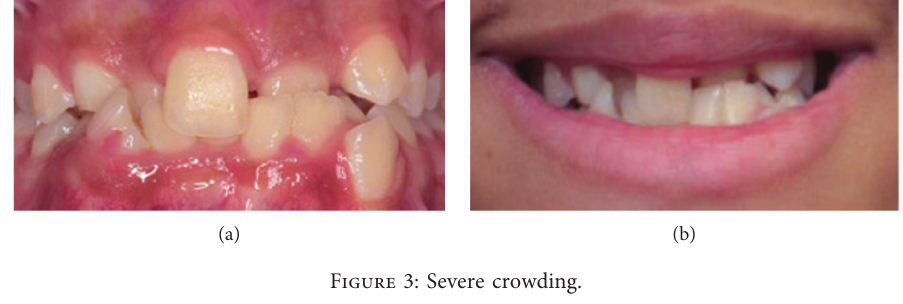
Figure 3: Severe crowding.